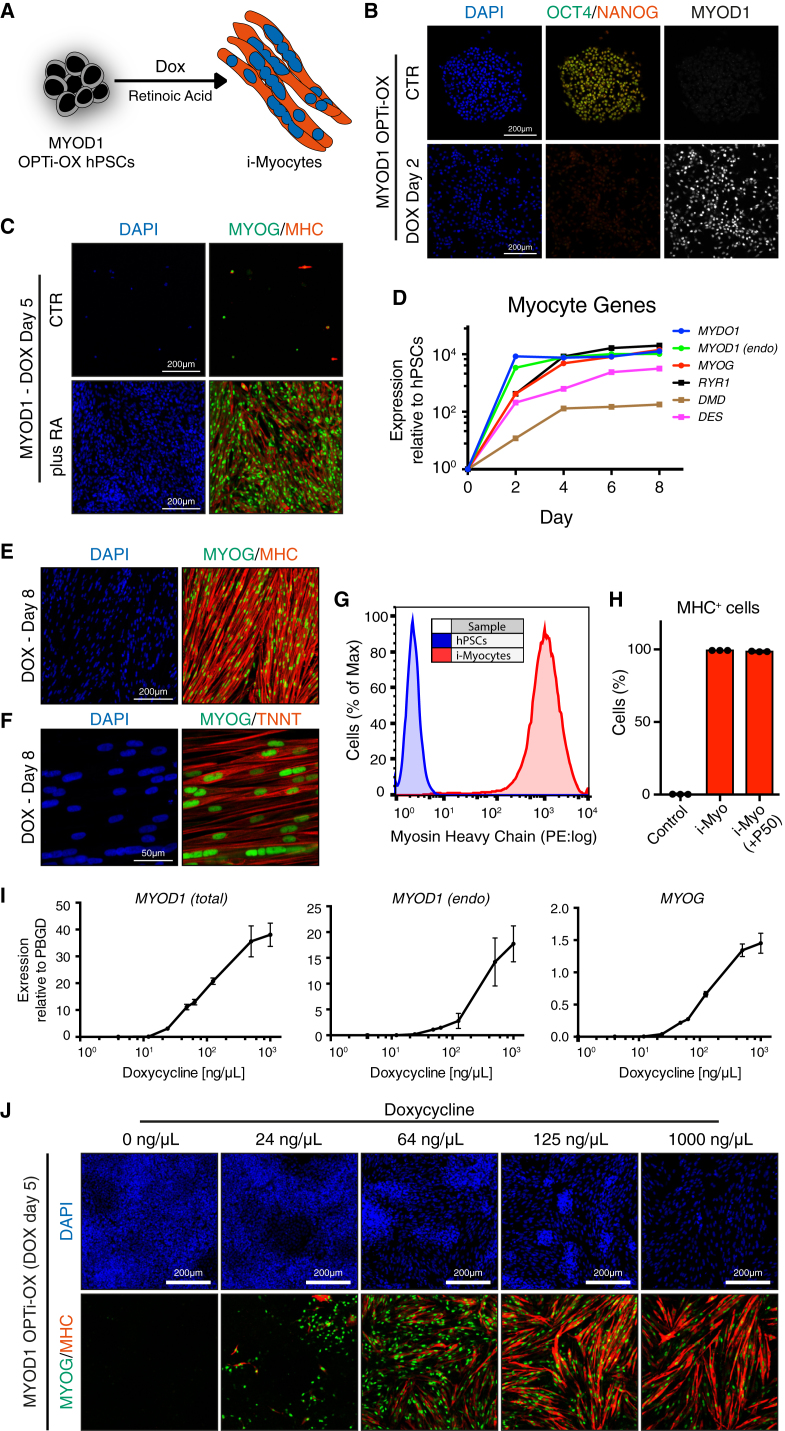
Forward Programming of hPSCs into Skeletal Myocytes(A) Experimental approach for rapid single-step conversion of MYOD1 OPTi-OX hPSCs into skeletal myocytes (i-Myocytes) following treatment with dox and RA.(B) Representative ICC for MYOD1 before (CTR) and after induction with dox. This demonstrates homogeneous induction of transgene expression, paralleled by downregulation of the pluripotency factors NANOG and OCT4.(C) Effect of RA on myocyte forward programming compared with otherwise identical control (CTR) induction conditions (see Figure S2B for the entire signaling molecule screen).(D) qPCR of the temporal expression pattern of pluripotency factors (top panel) and myocyte marker genes during i-Myocyte generation (n = 3 biological replicates, mean ± SEM; relative to PBGD and normalized to pluripotency).(E and F) ICC for skeletal myocyte markers in i-Myocytes.(G and H) Quantification of MHC-positive cells by flow cytometry 10 days after induction. Undifferentiated cells were used as negative control, and figures are reported for i-Myocyte generation in newly isolated MYOD1 OPTi-OX hESCs, or in the same cells following 50 passages (+P50) (n = 3 biological replicates; mean ± SEM).(I) qPCR for total MYOD1, endogenous MYOD1, and MYOG 2 days post induction with different dox concentrations (n = 3 biological replicates; mean ± SEM).(J) ICC for myogenin and myosin heavy chain following 5 days of induction with different dox concentrations. Non-converted, proliferative cell clusters appeared when the dox concentration was lowered to 0.125 μg/mL. Further reduction of dox resulted in an increase in non-myocyte cell populations.